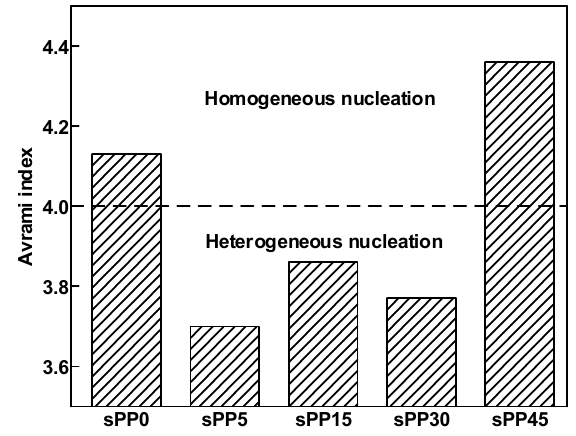
Figure 9. Differential scanning calorimetry (DSC) curves of iPP/sPP blends. Figure 9. Di ff erential scanning calorimetry (DSC) curves of iPP / sPP blends.